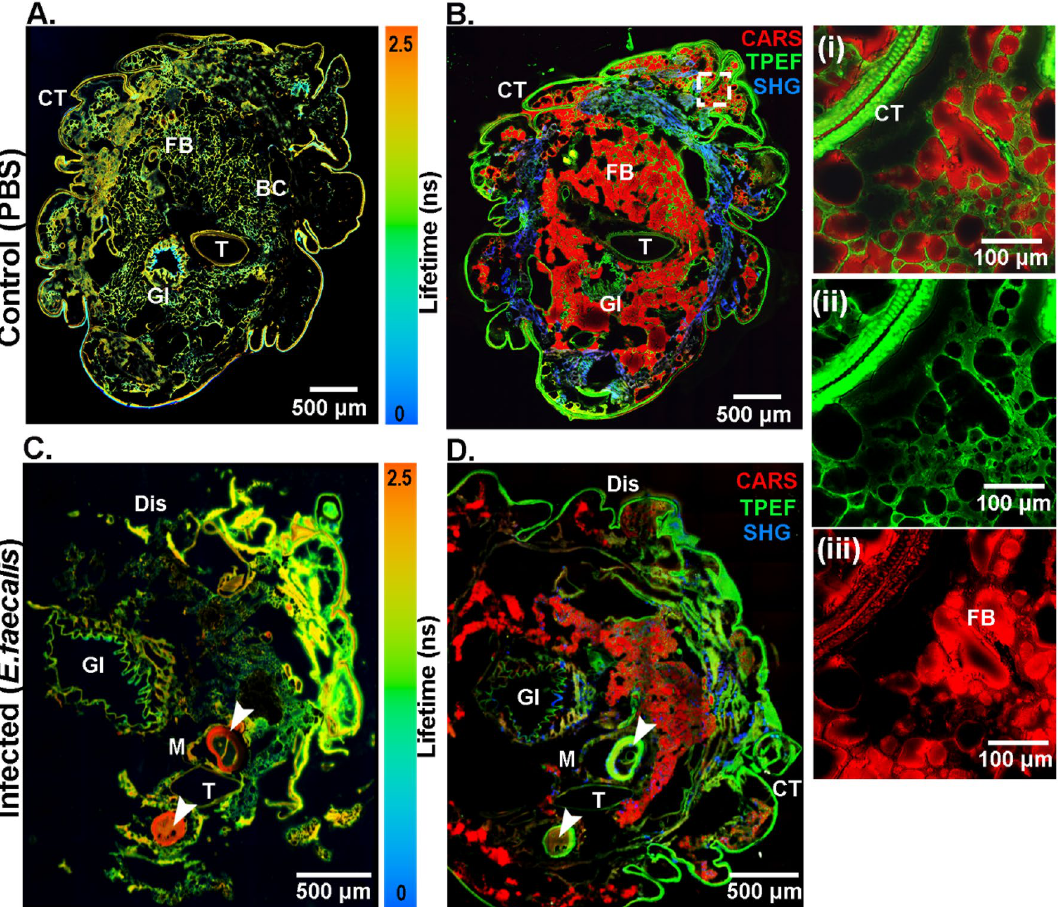
Figure 1. Multimodal images of transverse sections of control ( A , B ) and E. faecalis infected ( C , D ) tissues from G. mellonella larvae highlight the tissues’ morpho-chemical information. ( A , C ) The FLIM images illustrate transverse sections corresponding to endogenous fluorophores such as flavins and lipo-pigments with differing lifetime information as false-color images ranging from blue to red (scale 0–2.5 ns). ( B , D ) The CARS (red), TPEF (green), and SHG (blue) channels were merged as indicated in false colors. The square inset with dashed lines in ( B ) was zoomed and shown in the composite image ( i ), the TPEF channel in green ( ii ), and the CARS image in red ( iii ). M = dislocation of the membrane around tubular organs, Dis = distorted cuticle structure, BC = body cavity, FB = fat body, CT = cuticle, T = trachea, GI = denotes the lumen of the gastrointestinal tract, and white arrowheads point to silk